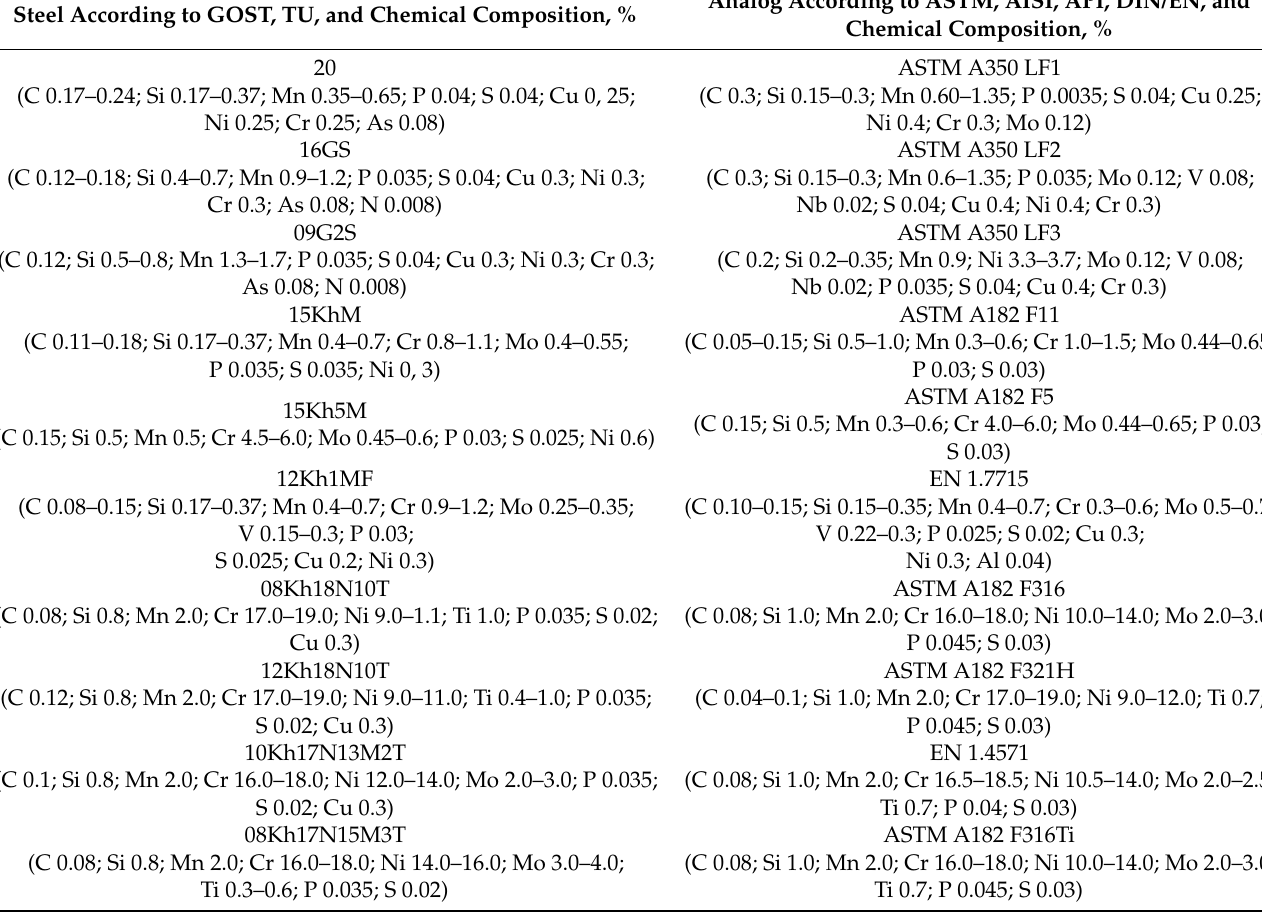
Table 11. Steels recommended for use in hydrogen-containing media at temperatures up to 463 K and pressures up to 40 MPa [83]. Steel According to GOST, TU, and Chemical Composition, %